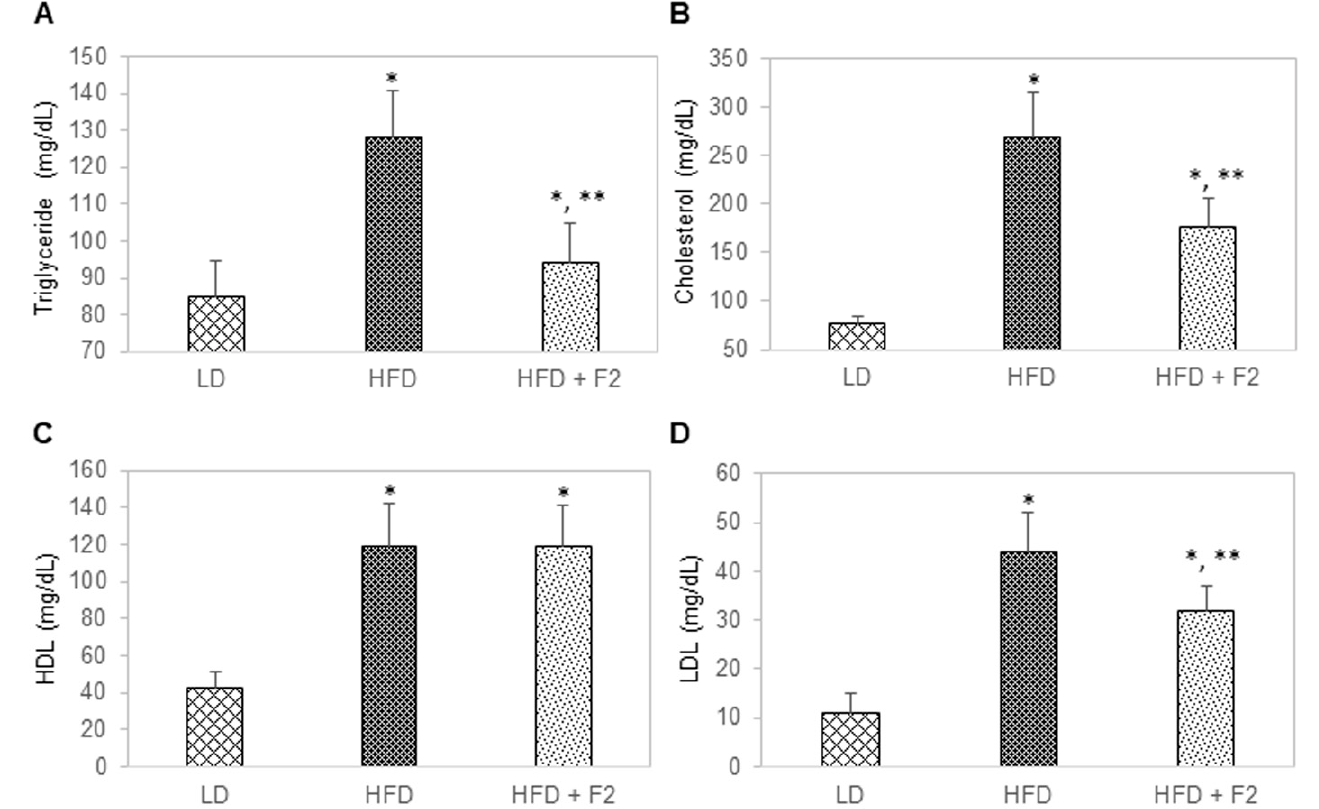
Figure 7. F2 composition reduces blood lipids in diet-induced obesity mice. ( A ) Triglyceride, ( B ) cholesterol, ( C ) high-density lipoprotein (HDL), and ( D ) low-density lipoprotein (LDL) as a function of animal group on specified diets. LD: Lean diet; HFD: High-fat diet; HFD + F2: High-fat diet supplemented with F2. Blood samples terminally collected after 17 weeks on specified diets were used for measurement. The error bars indicate the standard deviations of 40 mice per animal group. Single asterisk (*) indicates a statistical significance of p -value ≤ 0.01 versus the lean diet group. Double asterisk (**) indicates a statistical significance of p -value ≤ 0.01 versus the high-fat diet group.